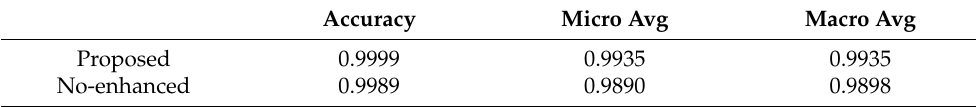
Table 4. Comparison of results before and after using data enhancement